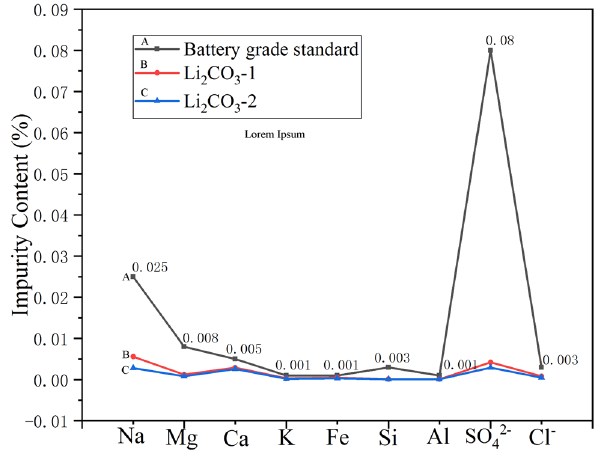
Figure 6: Comparison of the Li 2 CO 3 battery - grade standard and product impurity content for several common